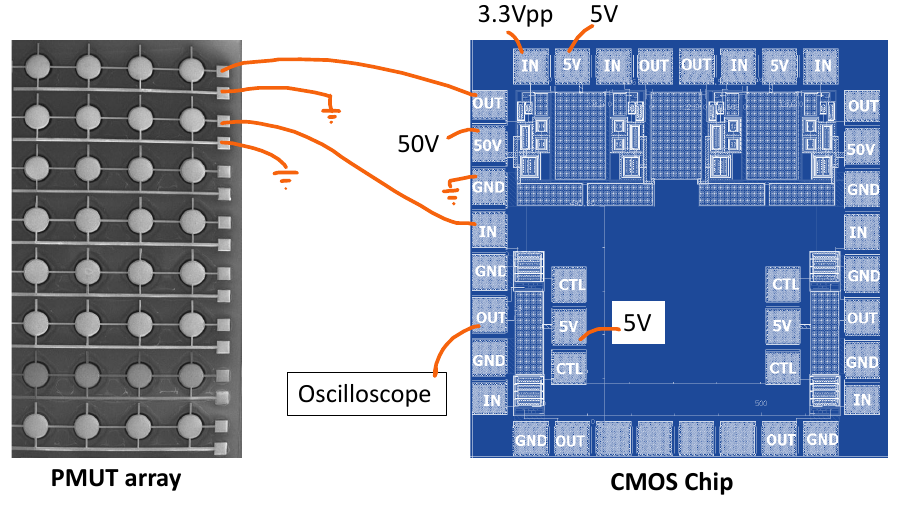
Figure 8. Schematic of the wire-bond connections between the CMOS chip and the PMUT